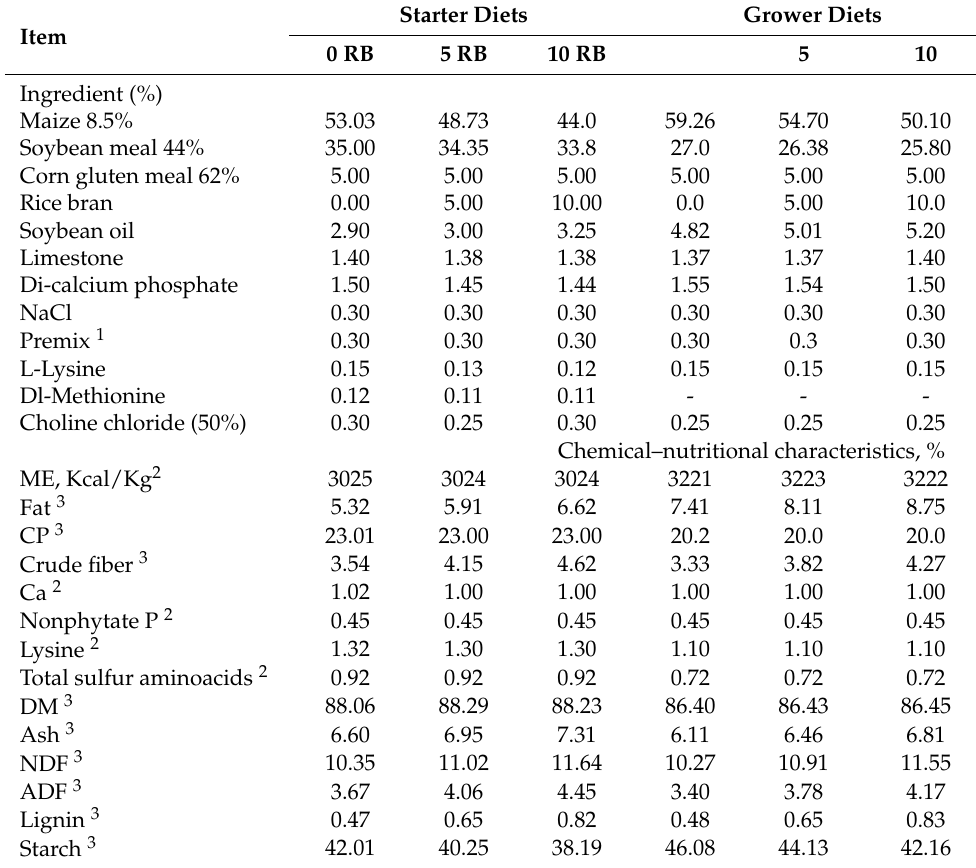
Table 2. Composition of the experimental (starter 8–21 d) and grower (22–35 d)